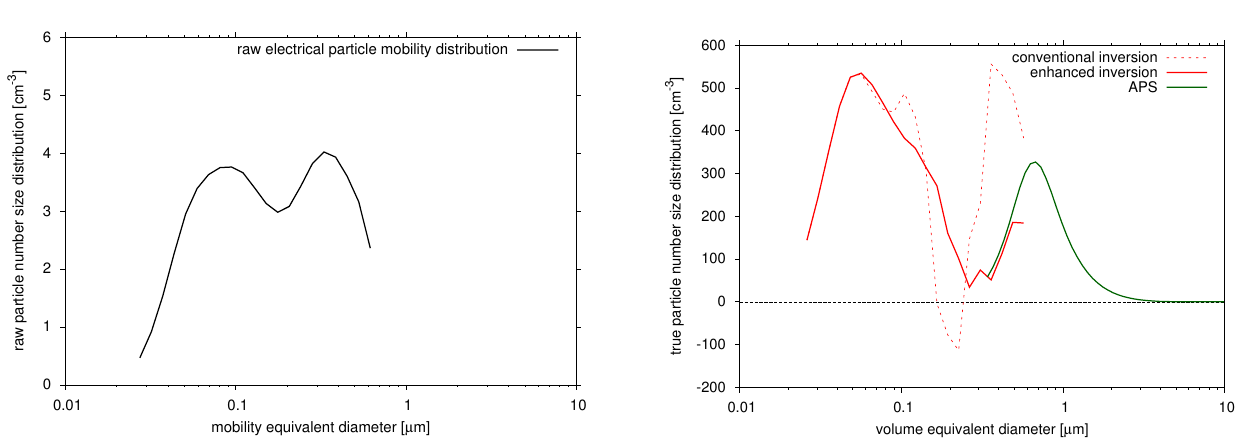
Fig. 3a. Raw electrical particle mobility distribution (EPMD) in Fig. 3a: raw electrical particle mobility distribution (EPMD) plain concentration. Fig. 3b: Results of the particle number size distribution in plain concentration